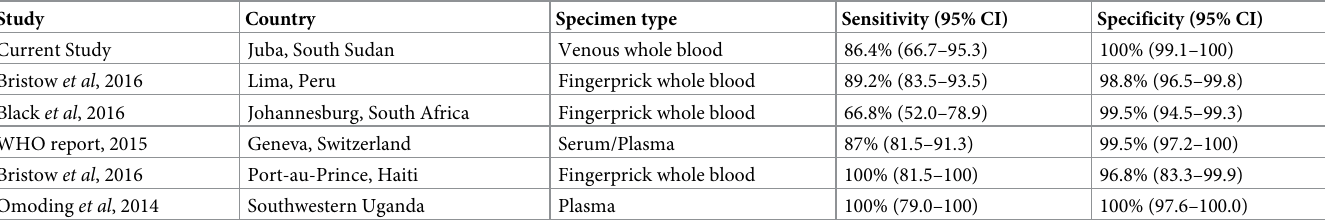
Table 3. SD Bioline Duo test syphilis results for field studies verses laboratory-based